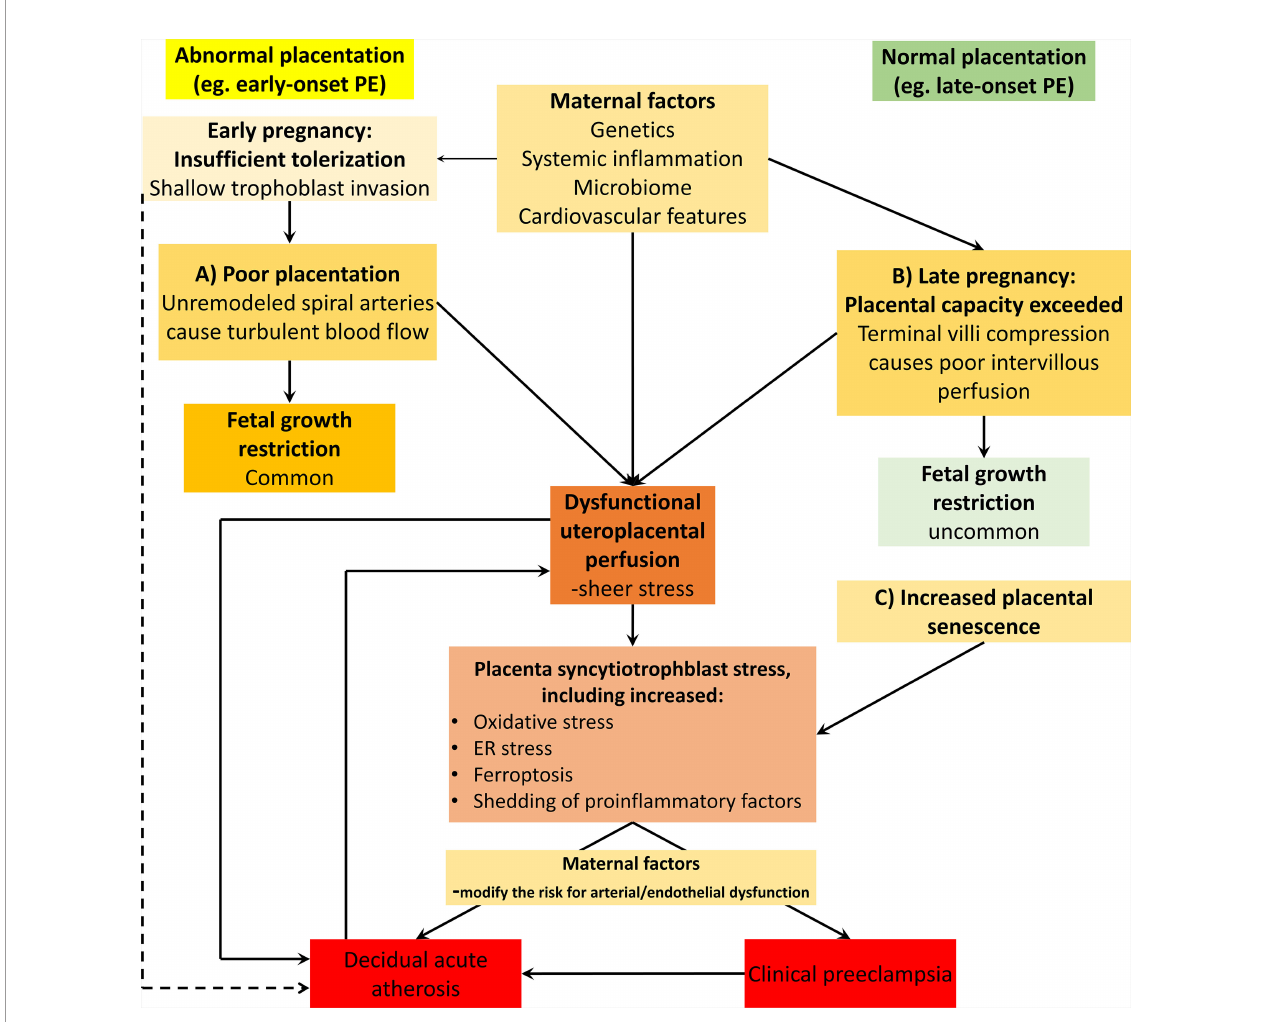
FIGURE 2 | Acute atherosis presence across the several forms of placental syndrome forms. Acute atherosis has been found in several forms of placental syndromes, many of these associated with spiral artery remodeling de fi ciencies, including early-onset preeclampsia (PE) (illustrated on the left side of the Figure). This fi gure also illustrates our concepts of how acute atherosis may be present also in late forms of preeclampsia (illustrated on the right side of the Figure), or indeed in any other forms of placental dysfunction without spiral artery remodeling defects. Preplacentation factors impacts the early and ensuing placentation processes, and includes both fetal-maternal tolerization processes as well as endometrial health (92). In this model, acute atherosis is seen as a consequence of any form of placental dysfunction and its underlying mechanisms (69). The triggers include both the uteroplacental malperfusion pathway secondary to spiral artery remodeling problems (as in early-onset preeclampsia) as well as the late-onset preeclampsia forms with other causes of placental malperfusion and syncytiotrophoblast stress (92, 93). Furthermore, this model also proposes that acute atherosis itself may represent a risk factor for placental dysfunction and preeclampsia. This is in line with acute atherosis developing very early in women with excessive vascular in fl ammation, such as in systemic lupus erythematosus, who also have a high risk for developing early-onset preeclampsia, severe fetal growth restriction and intrauterine death, all severe clinical aspects of placental dysfunction. The line from the tolerization box to acute atherosis illustrate how HLA-C/KIR interactions and alterations in level of immune-dampening molecules such as sHLA-G could contribute to lesion promotion at the maternal-fetal interface, as discussed in this review. The maternal factors promoting the clinical forms of preeclampsia (e.g. early- and late-onset) as well as atherosis development include cardiovascular, in fl ammatory and metabolic factors. Also, any form of clinical preeclampsia, with excessive circulation of proin fl ammatory factors and hypertension may add to the risk for atherosis development, although hypertension in itself is not a mandatory